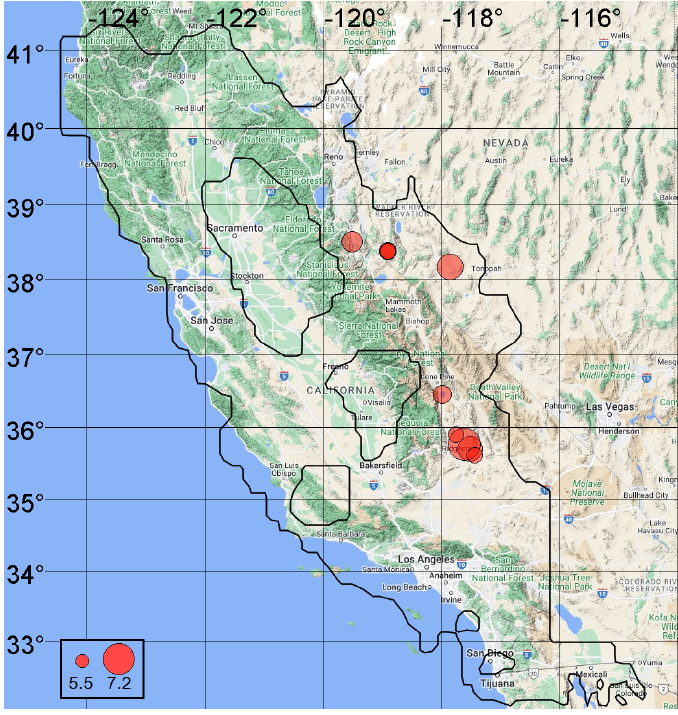
Figure 6. Analysis zone and epicenters of test earthquakes in the interval 1 January 2008–5 February 2023 with magnitudes m ≥ 5.5 and hypocenter depths H ≤ 60 km.